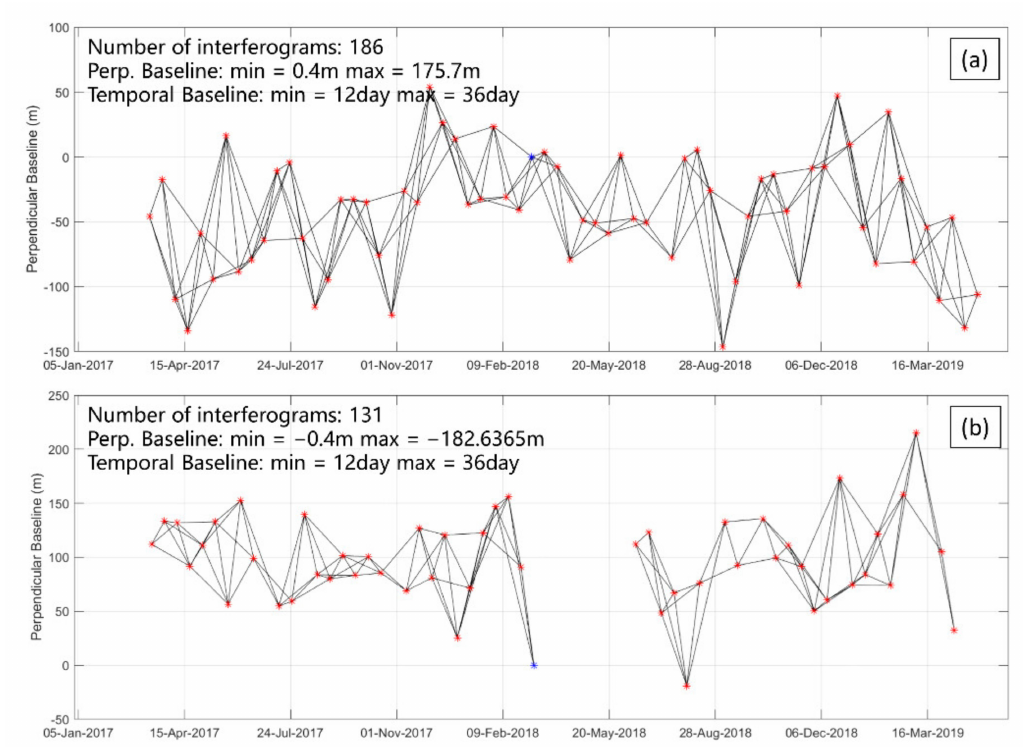
Figure 4. Spatiotemporal distributions of accepted unwrapped interferograms. ( a ) Ascending Sentinel-1 dataset for Track 26 and ( b ) descending Sentinel-1 dataset for Track